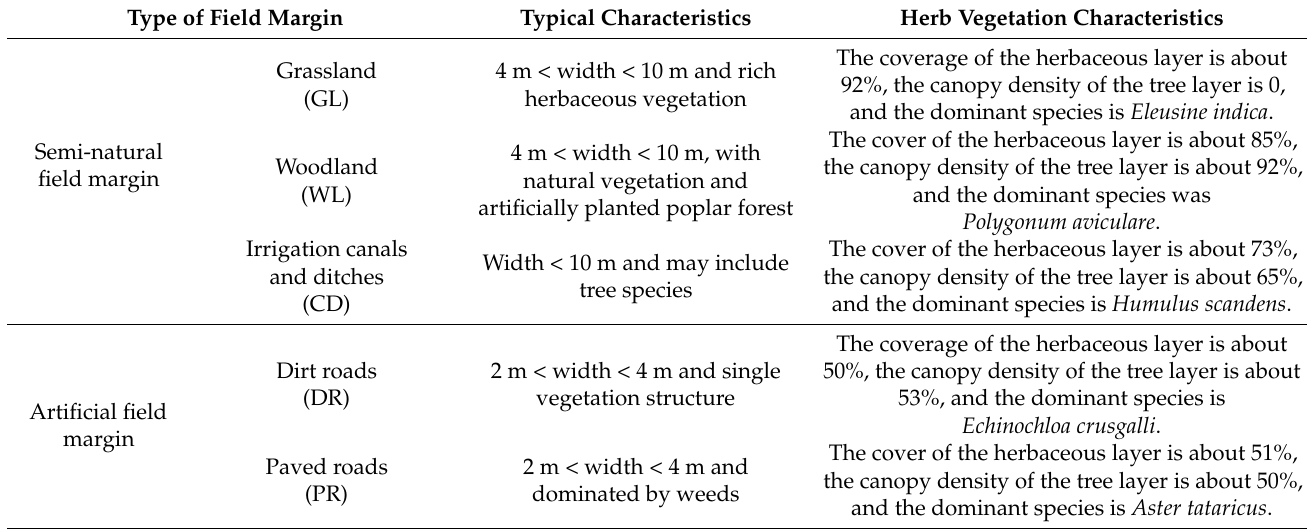
Table 1. Five types of field margins, their typical characteristics, and vegetation characteristics. More detail on the field margins monitored can be found in Text